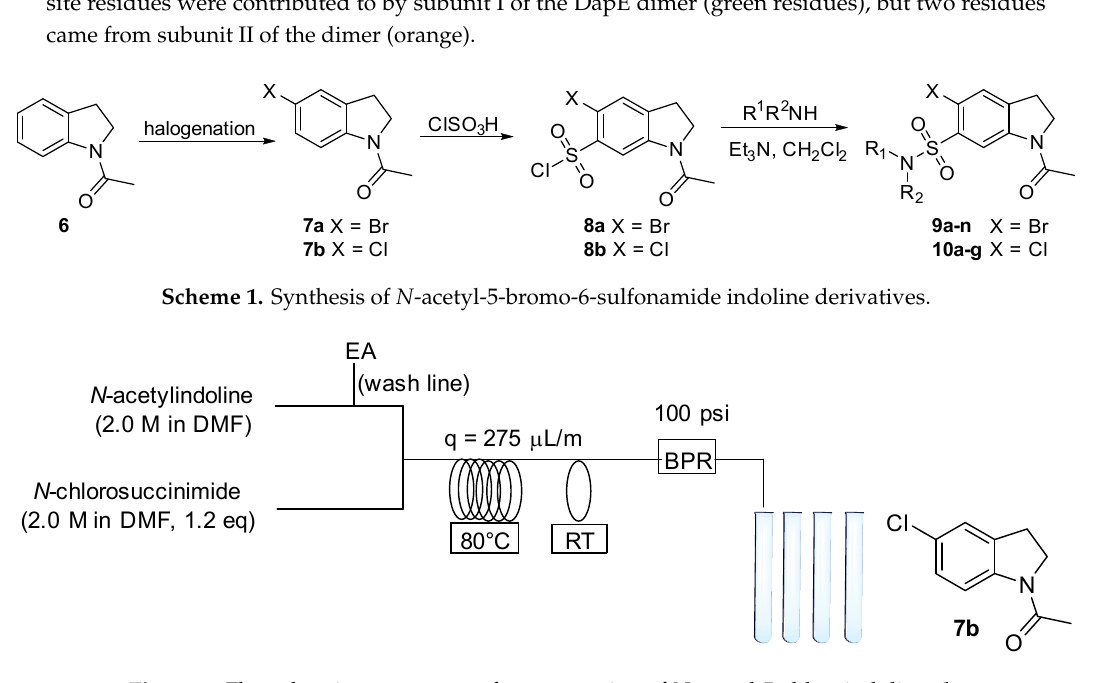
Figure 4. Flow chemistry apparatus for preparation of N -acetyl-5-chloroindoline 7b .